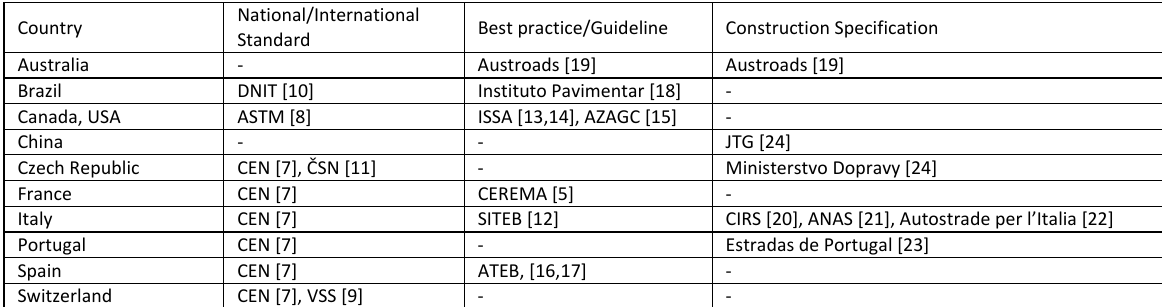
Table 1. List of the considered documents. Country